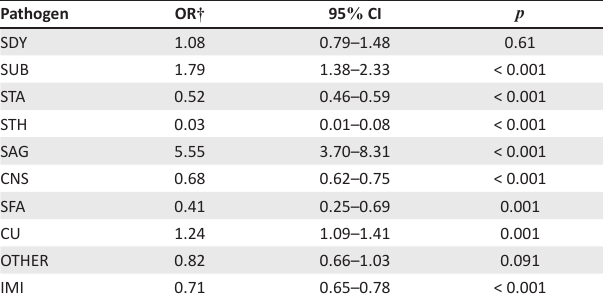
TABLE 2: Comparison of mastitis pathogen prevalence between 2008 and 2013 after adjusting for system using multiple logistic regression. Pathogen